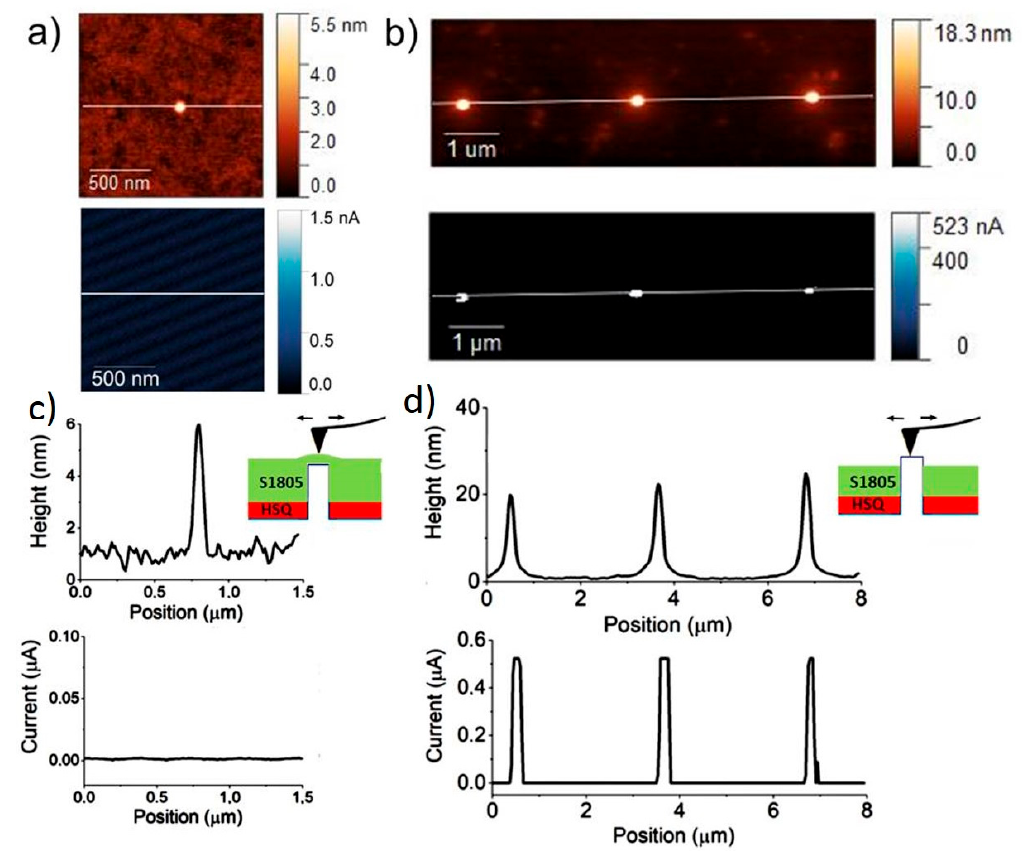
Figure 5. ( a ) Schematic of c-AFM measurement and ( b ) contact geometry on top of uncovered pillars; note that D is the pillar diameter, and d is the deformation due to contact in the z direction and a is the estimated contact radius. In panels ( c ) and ( d ) c-AFM images (topography and current) of 100 nm diameter pillars acquired at 3 V bias are shown. ( c ) Images and corresponding height profiles of a single pillar before etch-back, since the pillar is buried into the resist, no current is detected ( d ) images and corresponding profiles of three revealed pillars after etch-back, current is measured on top of each pillar.